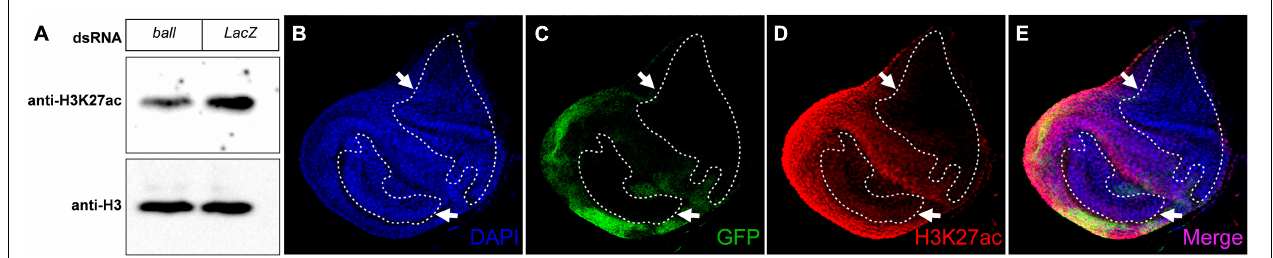
FIGURE 2 | Depletion of BALL affects H3K27ac levels. (A) Western blot analysis of whole cells lysates from Drosophila S2 cells treated with dsRNA against ball exhibit reduced H3K27ac. Cells treated with dsRNA against LacZ served as control while total levels of histone H3 were used as a normalization control in immunoblot. Analysis of the relative intensities of H3K27ac signal, normalized against total H3 levels using ImageJ, showed more than 37% reduction in H3K27ac upon ball depletion. Experiment was performed thrice and replicates are shown in Supplementary Figure 2 . (B–E) Haltere imaginal discs containing mitotic clones of ball 2 were stained with anti-H3K27ac (D) . Mitotic clones, marked by the absence of GFP, showed drastic reduction of H3K27ac. Imaginal discs showed uniform DAPI staining (B) . Mitotic clones are encircled and highlighted with arrows. The ex vivo knock down of ball was performed in triplicate while the mitotic clone experiment was performed in